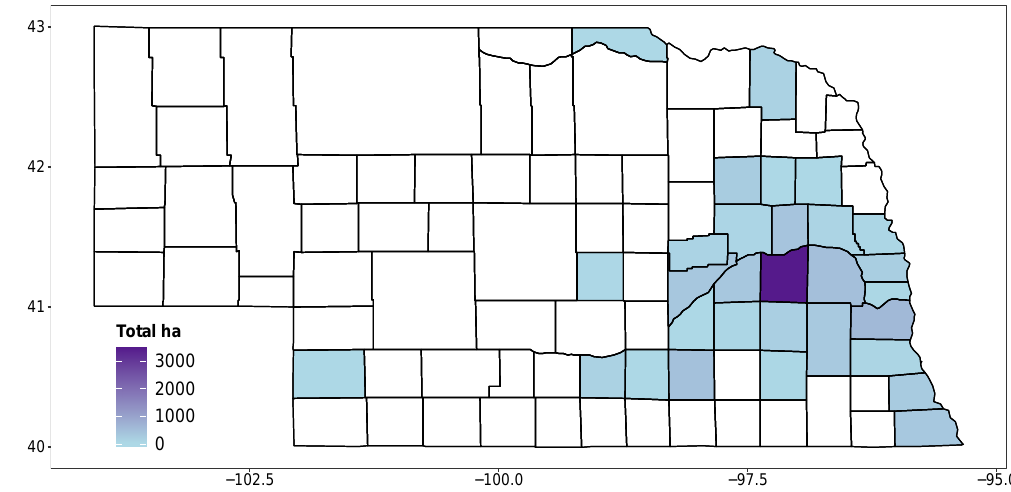
Figure 2. Map of Nebraska counties with the sum of total cover crop ha managed by survey respondents identified as growers. The dark purple color represents Butler County, where the 2017 Cover Crops Conference took